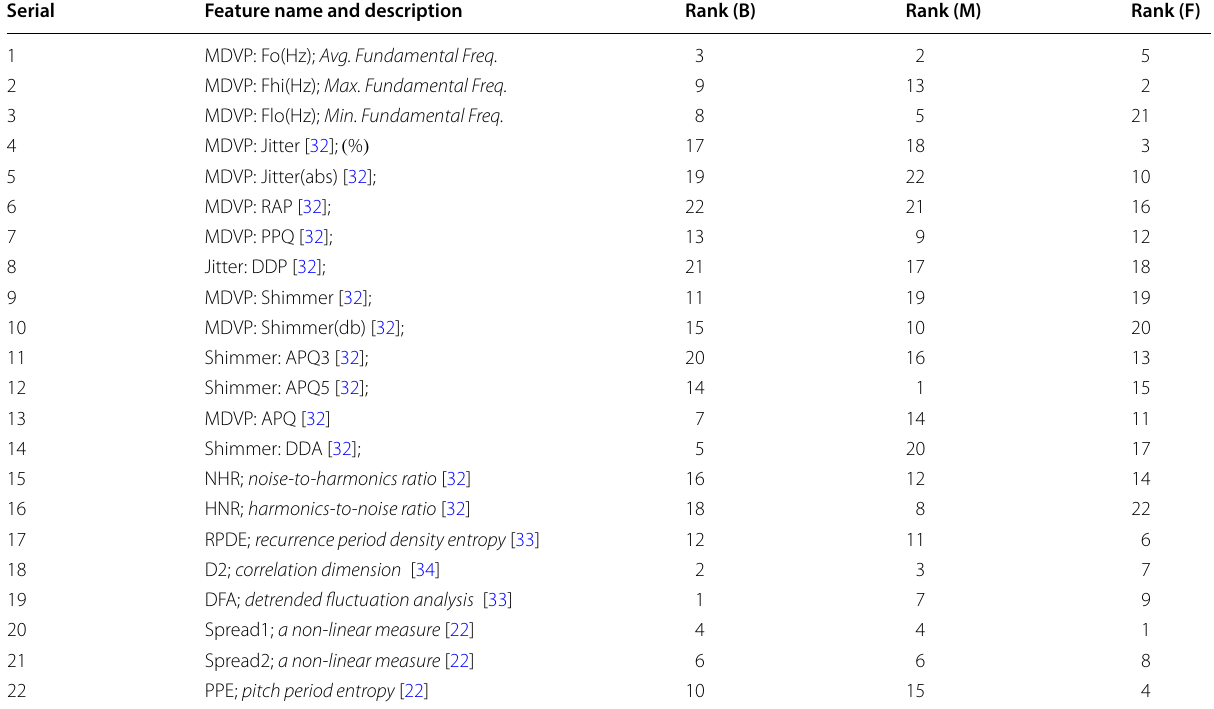
Table 5 Names and description of 22 voice features with their ranks calculated from both (B), only male (M) and only female (F) data